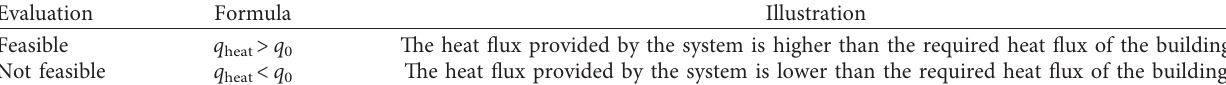
Table 1: Details of system evaluation.